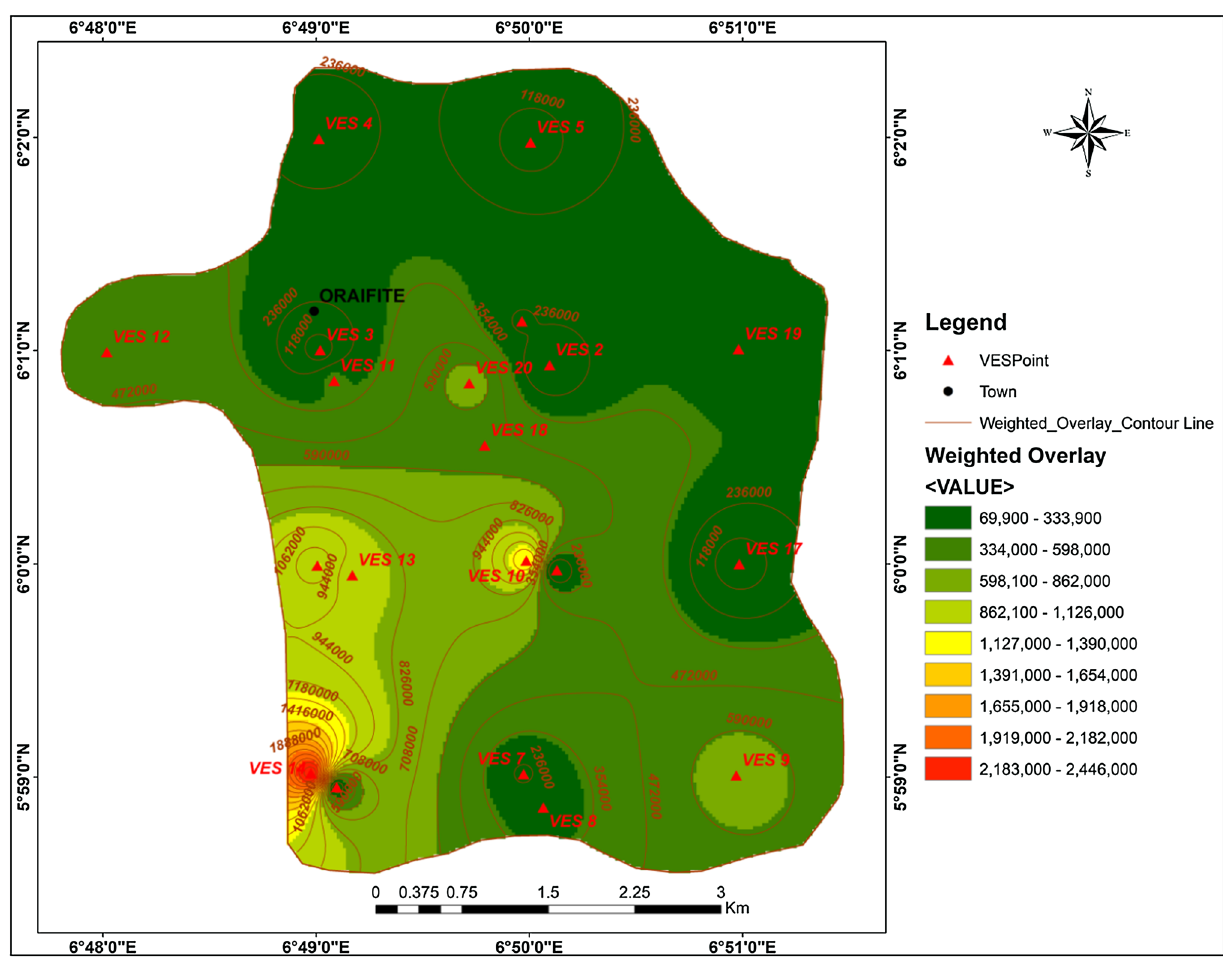
Fig. 9 Weighted overlay contour